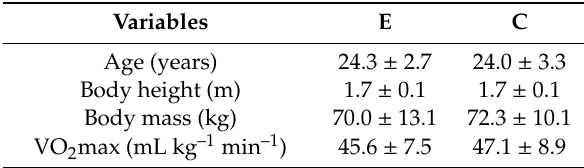
Table 1. Participants’ characteristics (mean ± standard